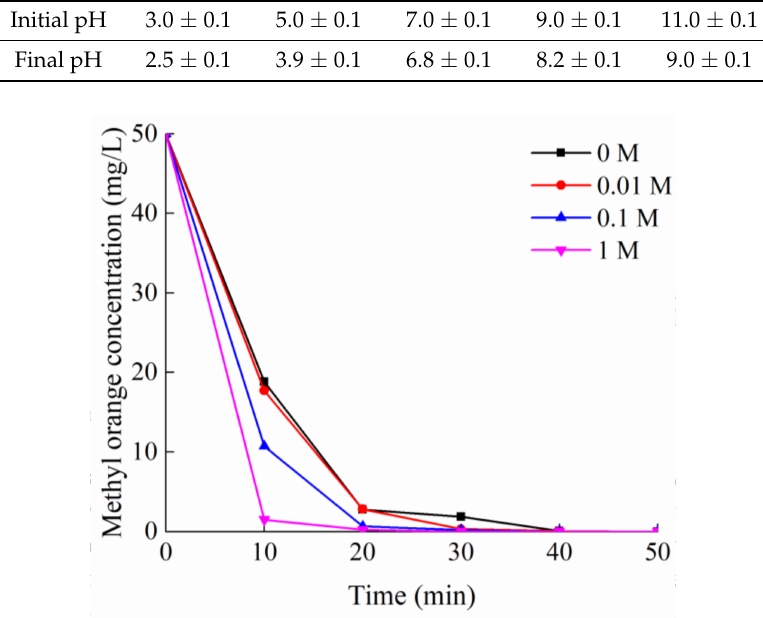
Table 3. Solution pH before and after treatment by ozone MNBs.